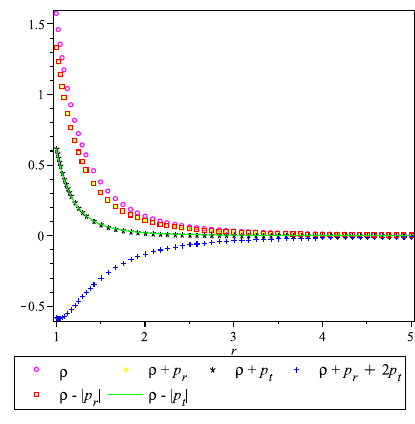
(b) This figure depicts the behavior of all EC terms for Model-I in Subcase 2 ( ξ 1 = 0, α 1 > 0, β 1 > 0, α < 0). NEC, WEC and DEC are found to be satisfied for every r > 0.